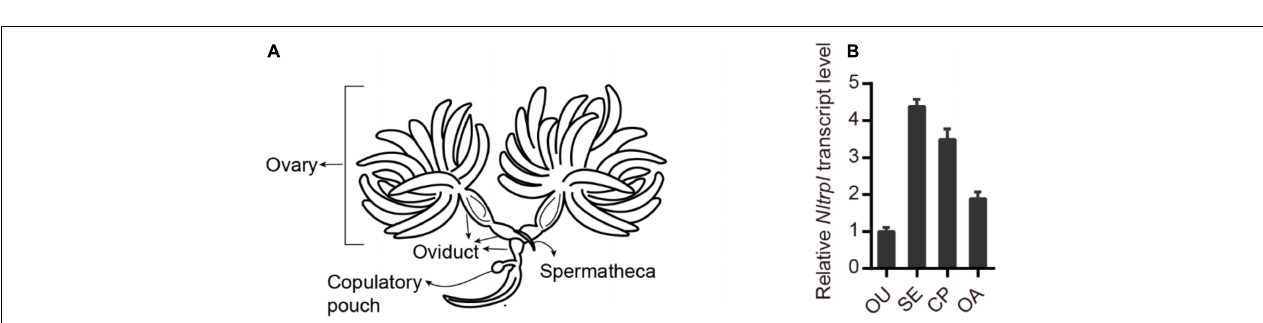
FIGURE 1 | Exon-intron organization in Nltrpl gene and phylogenetic analysis of NlTRPL and TRP family. (A) Exons are shown as black boxes. The lines between boxes represent introns. The predicted start codon (ATG), stop codon (TAG), and scaffold of the gene locus (“–” represents the opposite orientation with the scaffold) are also shown in their corresponding positions. The detail below shows the functional domains of Nltrpl . White cylinders represent ankyrin repeats (AR); purple boxes, transmembrane domain (TM); red box, pore structure; yellow box, TRP domain (EWKFAR and LPPPFN); blue box, coiled coil (CC). (B) Phylogenetic tree created using the maximum likelihood method in MEGA 5.2.2 software. The numbers at the nodes of the branches represent the numbers of bootstrap replications supporting that branch. The tree includes TRPL in Nilaparvata lugens (Nl, identified by the triangle), Drosophila melanogaster (Dm), Bombyx mori (Bm), Tribolium castaneum (Tc), Apis mellifera (Am), and Nasonia vitripennis (Nv), as well as other TRP channels in Drosophila . (C) Amino acid sequence alignment of NlTRPL and TRPL orthologs from Drosophila melanogaster (Dm), Apis mellifera (Am), Tribolium castaneum (Tc), and Bombyx mori (Bm). The amino acid position is shown on the right. Identical residues among orthologous sequences are shown as white characters against a black background, and conservative substitutions are shown as gray shading. Black rectangles above the sequence represent the transmembrane domain (TM); white rectangles representing the ankyrin repeat (AR); the red rectangle representing the pore domain; the yellow rectangle representing the TRP domain. The accession numbers of the sequences used are listed in Supplementary Table 2 .